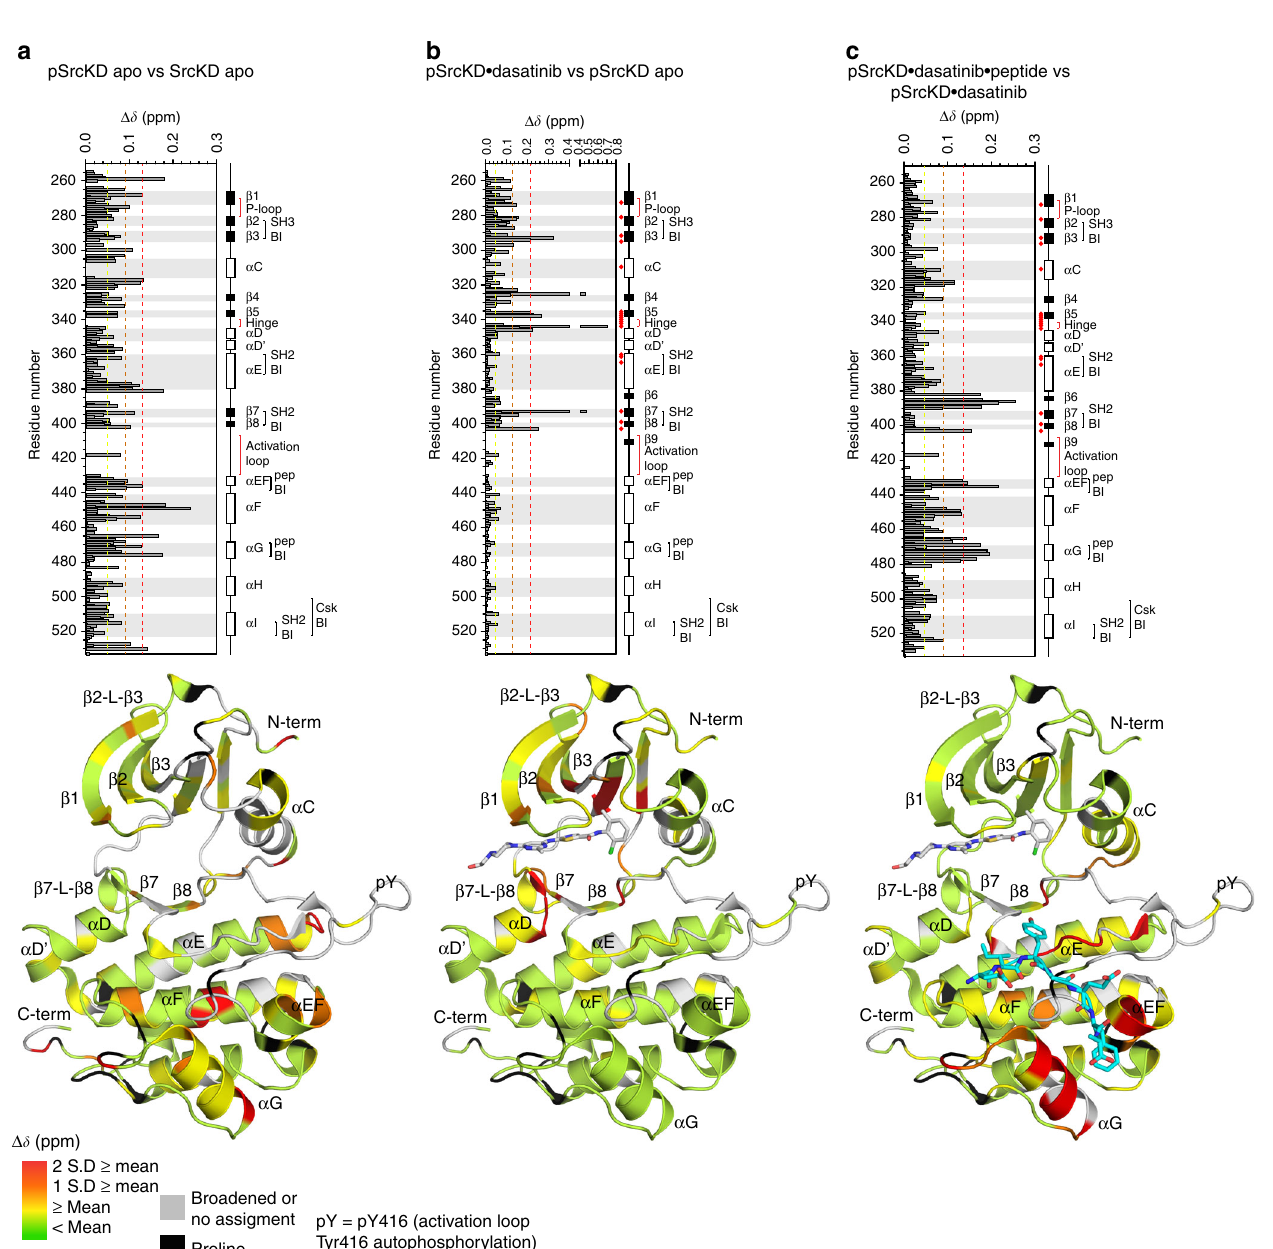
Fig. 5 Signals that promote the active kinase conformation induce distinct CSPs at long-range sites. The CSPs induced in SrcKD by activation state stabilizing signals: a activation loop autophosphorylation, b plus dasatinib binding, c plus substrate peptide binding, were analyzed by histograms and structure mapping to investigate their allosteric effects. Activation loop autophosphorylation induces long-range CSPs in SrcKD affecting regulatory sites including for example helix- α F. Dasatinib binding induces CSPs predominantly around the ligand binding site with few long-range CSPs propagating to helices- α E, α F. Substrate peptide-binding induces CSPs predominantly around the substrate peptide-binding interface with long-range CSPs occurring in helices- α C, α E, and the carboxy-terminal tail. The structure was generated using PDB 1YI6, and dasatinib from PDB 3G5D, which was superimposed into the active site by structural alignment. The substrate peptide (backbone shown in cyan) was computationally docked